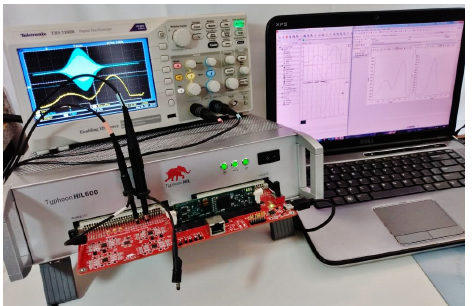
Figure 22. HIL simulator, with interface board and attached micro